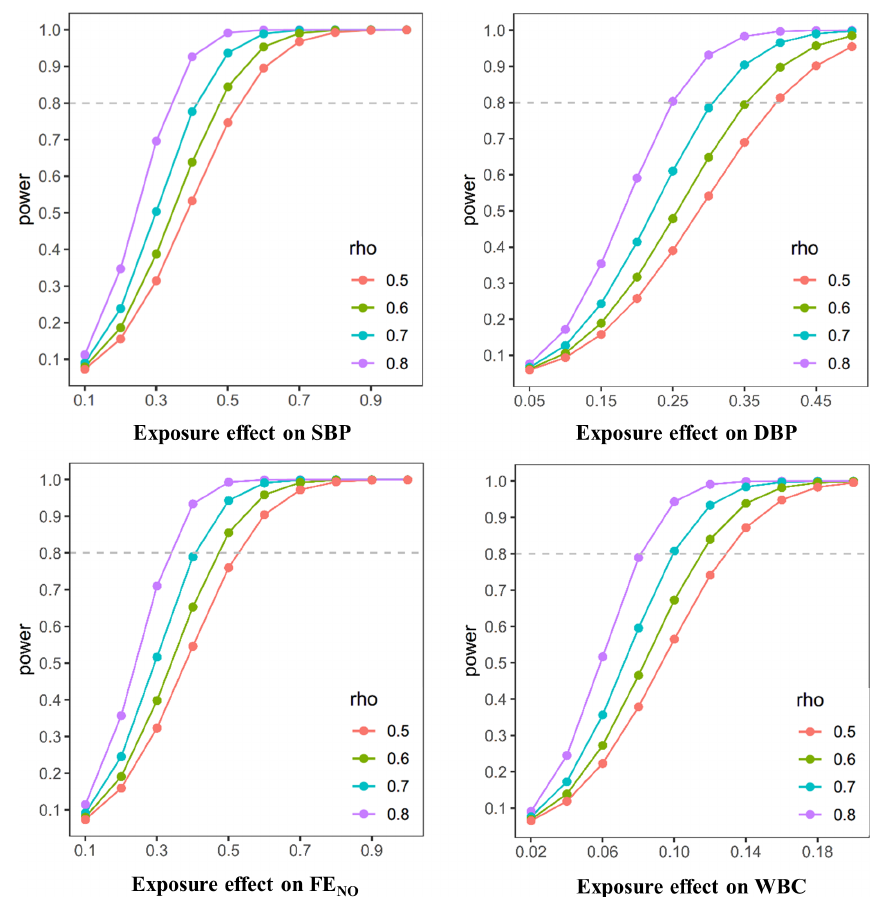
Figure 5. Statistical power as functions of the detectable effect and covariance structure for cardiopulmonary outcomes. Power curves are calculated by using a sample size of 240, within-participant correlation coefficients (as denoted by rho) of 0.5 and 0.8, and estimated SDs of 7.0, 5.2, 6.9, and 1.69 for outcomes SBP, DBP, FE NO , and WBCs respectively. Changes in outcomes are reported with SD increase in